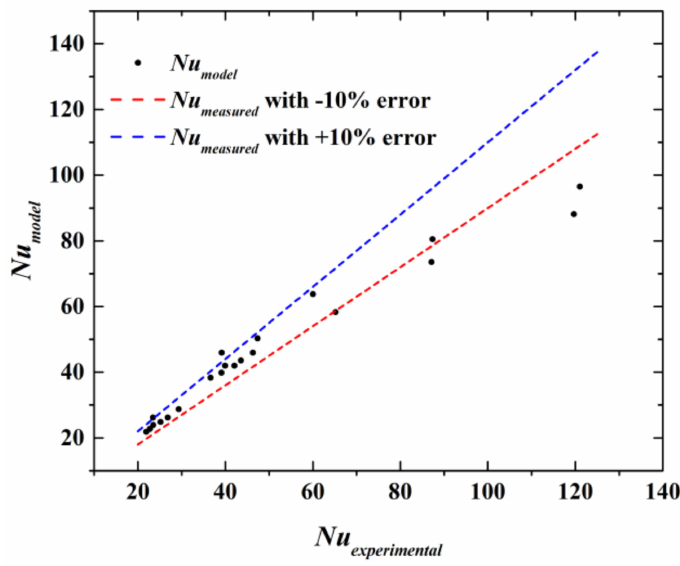
Figure 17. Comparison of experimental and predicted Nu values.